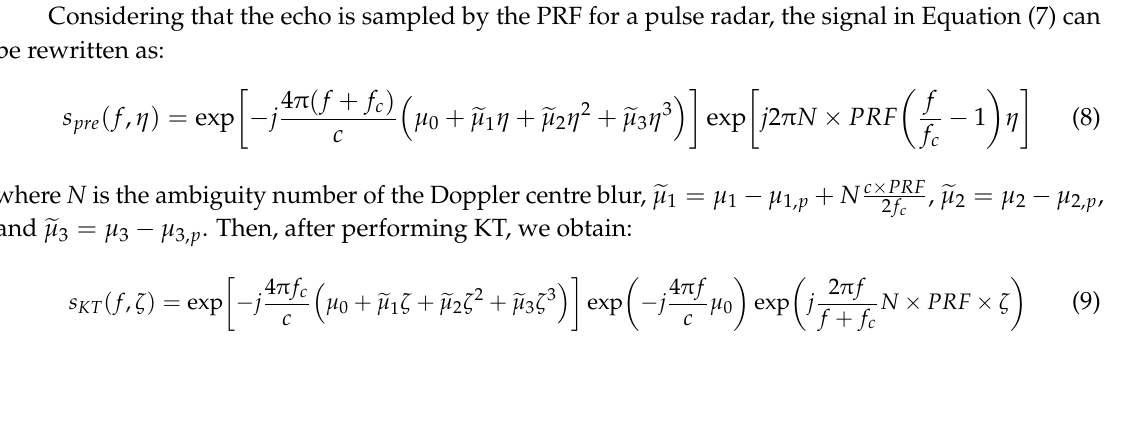
Figure 7. Simulated results for pre-processing: ( a ) remaining range migration; and ( b ) remaining DFM.